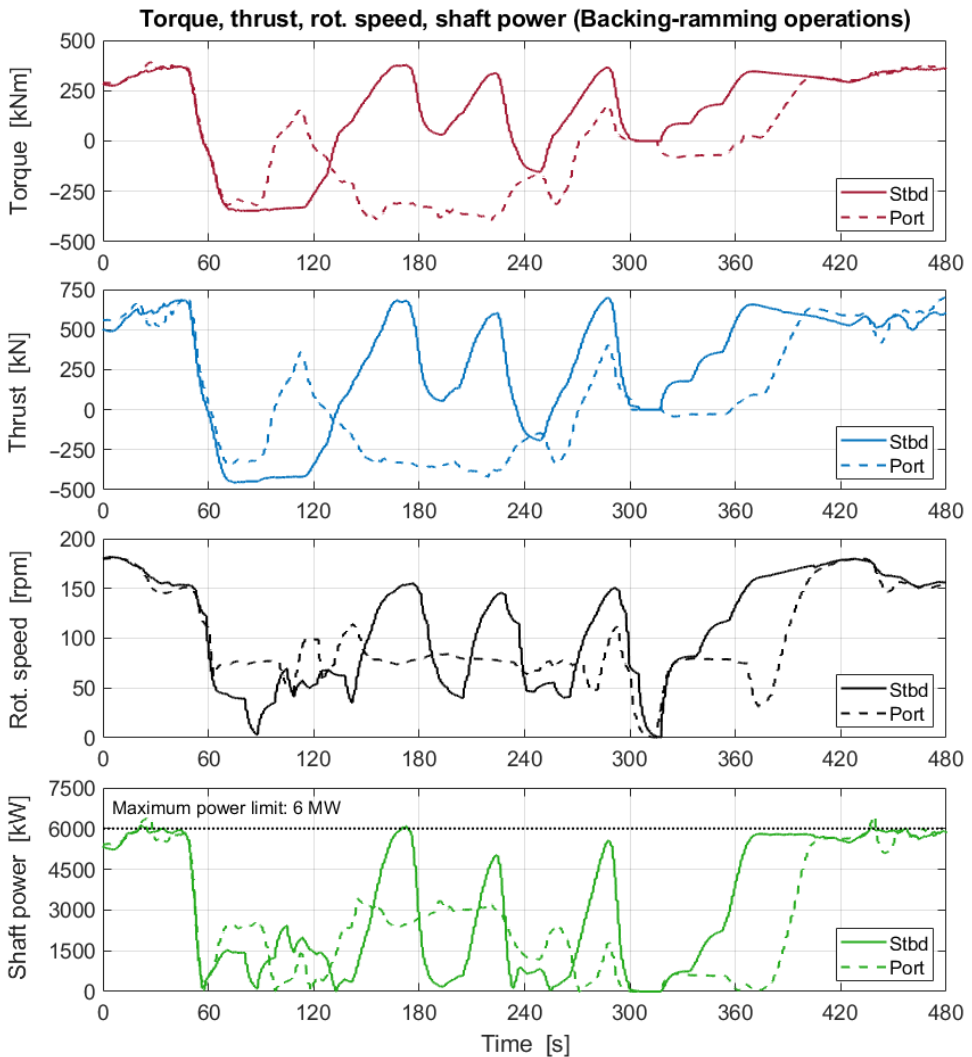
Figure 21. Time series of Q , T , and n during baking-ramming icebreaking operations, on 17 March 2020. The data series of both shafts’ sensors are